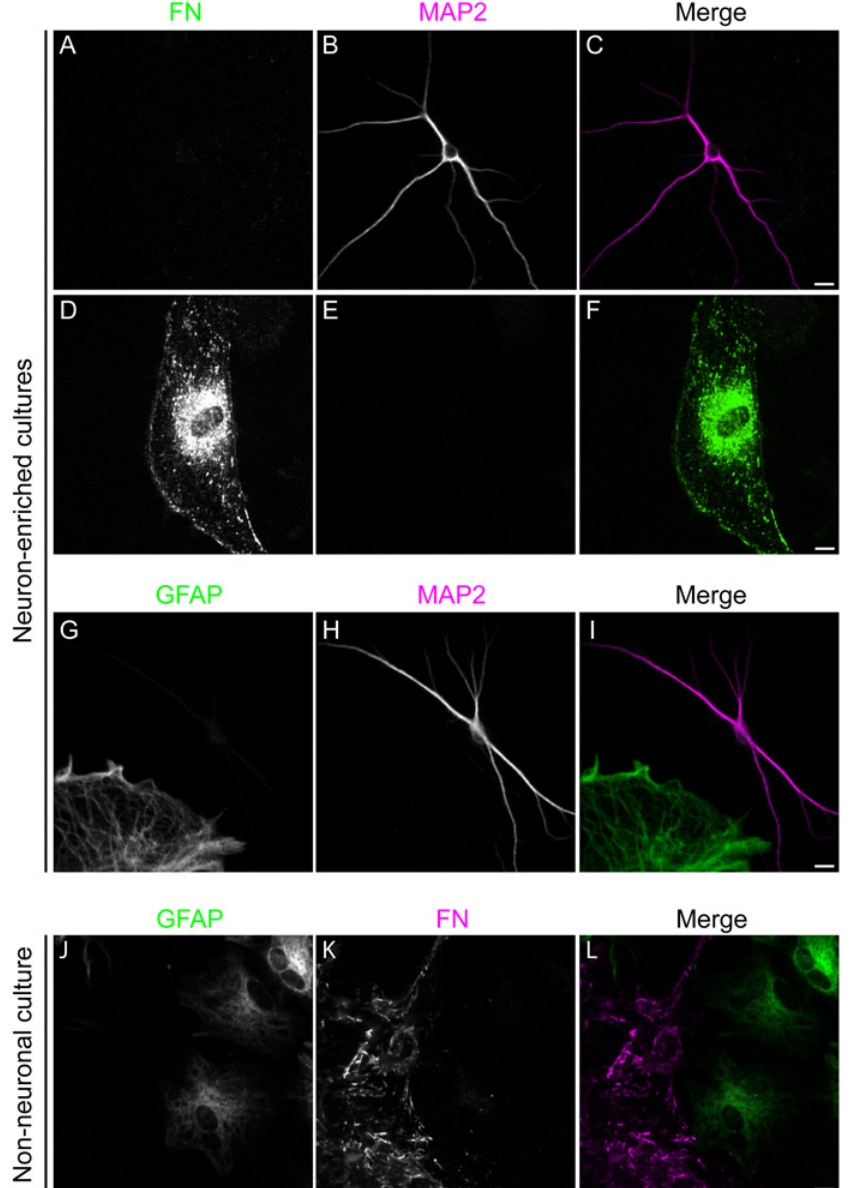
Fig 2. Identification of cell types isolated from adult Syrian hamster brain. Primary cells isolated from the brain of an adult Syrian hamster were cultured in vitro in NABG (Neuron-enriched) or DMEM+ (Non- neuronal), fixed and then stained for the presence of marker proteins for specific cell types. Neuron-enriched cultures were co-stained for the presence of the neuronal marker protein MAP2 (magenta) and the fibroblast marker fibronectin (FN, green) (shown in A-F) or MAP2 and the astrocyte marker protein GFAP (shown in G- I). Non-neuronal cultures were double stained for the presence of GFAP (green) and FN (magenta) (shown in J-L). Bar = 10 μ